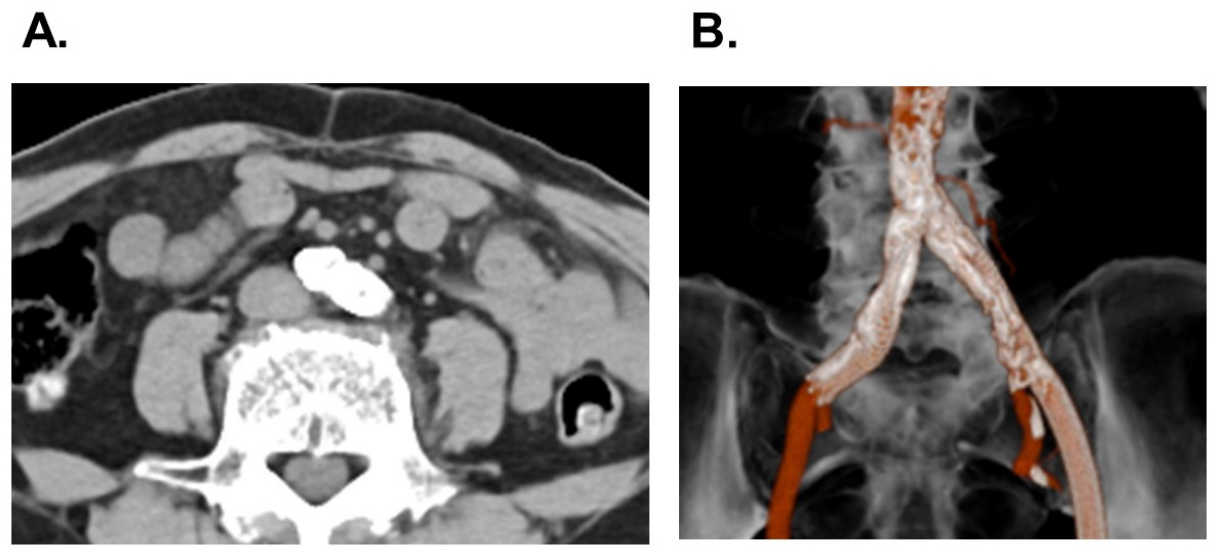
Figure 3. Abdominal computed tomography as a horizontal view ( A ) and three ‐ dimensional view ( B ) on admission, possessing bilateral common iliac stents with small in ‐ stent lumens.